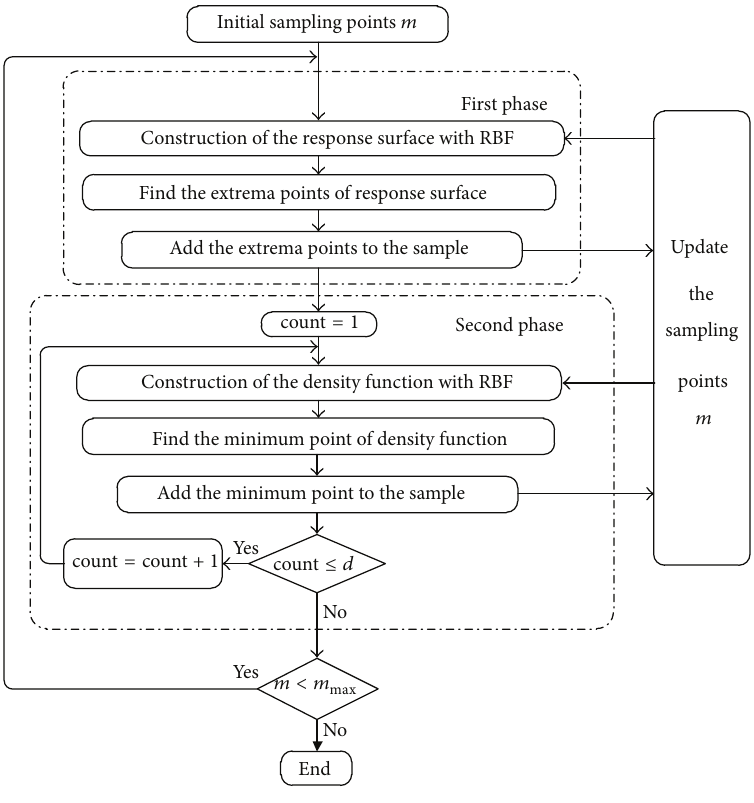
Figure 6: Proposed